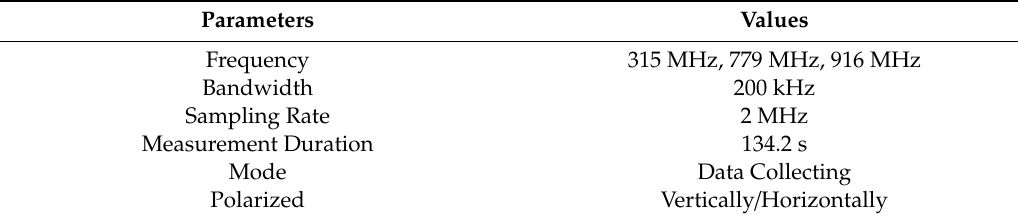
Table 2. Parameters of time domain